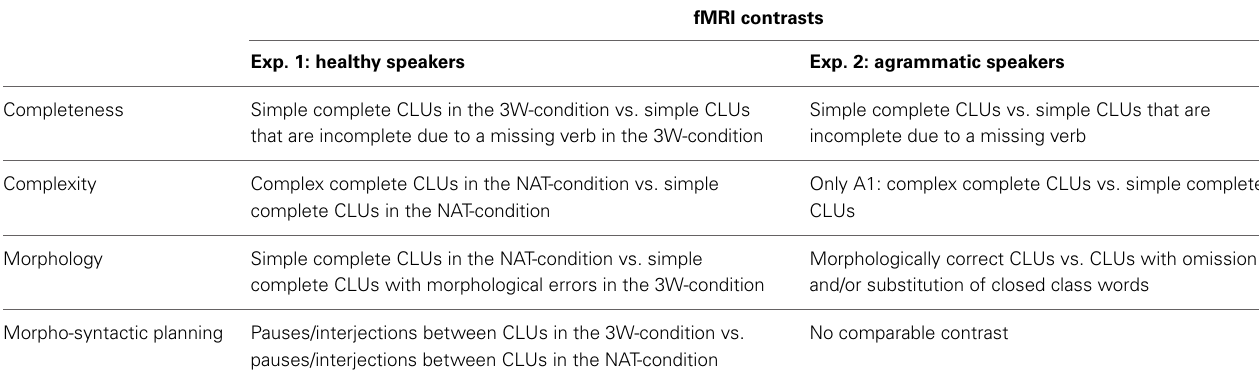
Table 2 | Calculated t-contrasts for the different morpho-syntactic